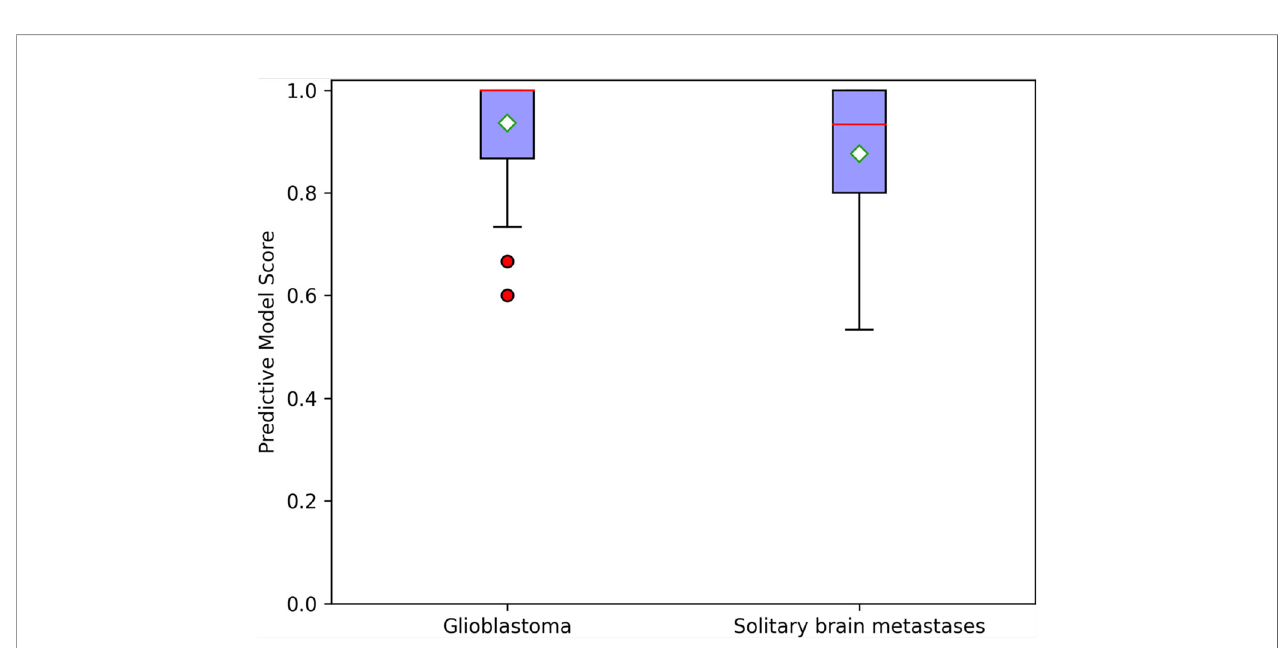
FIGURE 5 | Random forest classi fi er scores for glioblastoma and solitary brain metastases in the validation cohort; the red line indicates median, and the white diamond represents average prediction score.